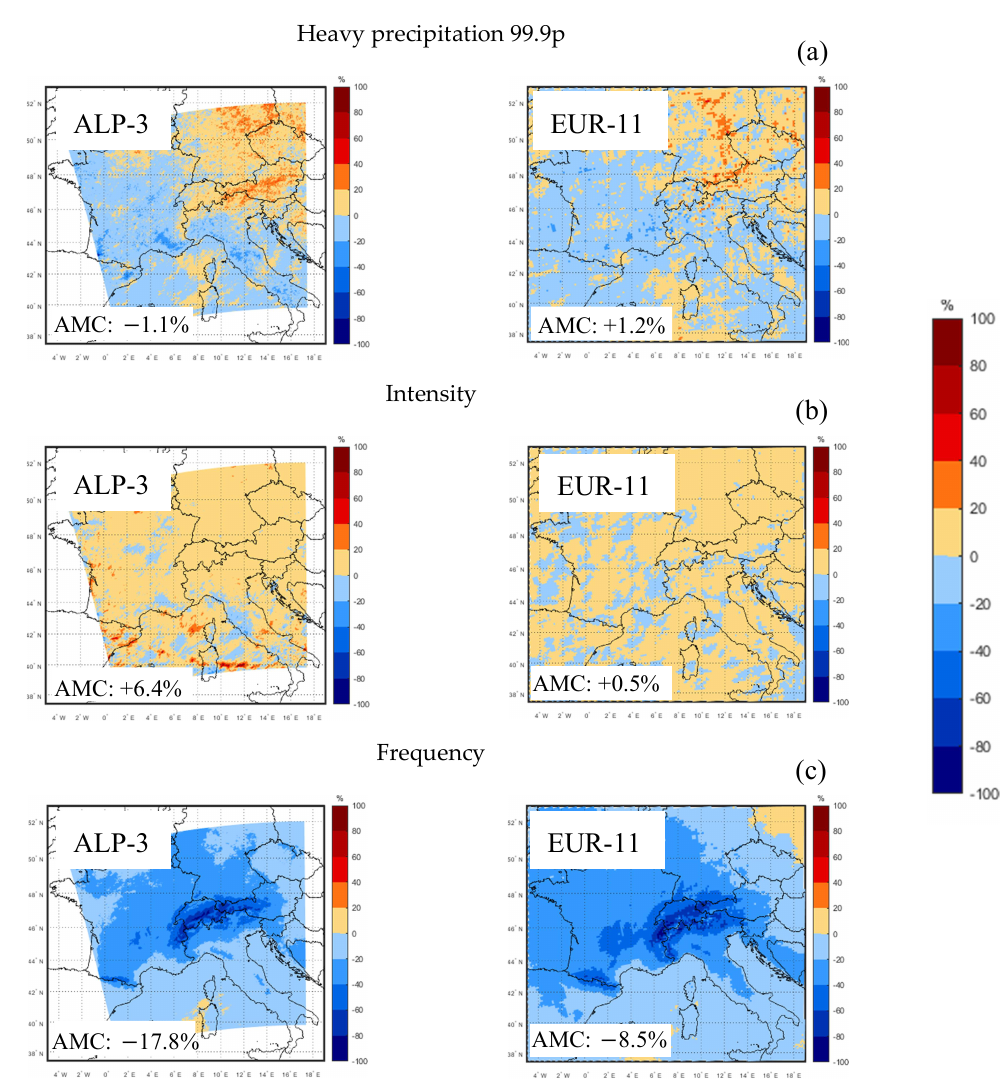
Figure 7. Changes in hourly heavy precipitation ( a ), intensity ( b ) and frequency ( c ) related to summer season (JJA) projected at the end of century (2090–2099) with respect to the historical period